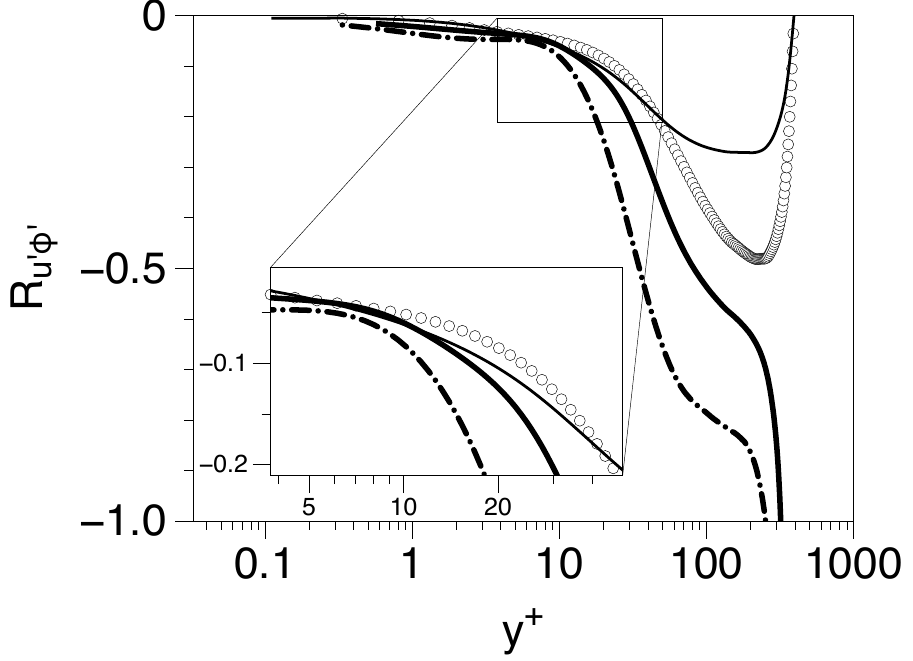
Figure 9. Model predictions for the scalar ratio R u (cid:48) φ (cid:48) for a Poiseuille flow at Re τ = 395 and Pr = 7. Comparison is made with DNS predictions for the stress ratio R 12 / R 11 (thin line) and the scalar ratio (symbols). The thick solid line denotes the proposed model and dash-dotted line denotes Younis’ model. Zoomed view refers to the near-wall